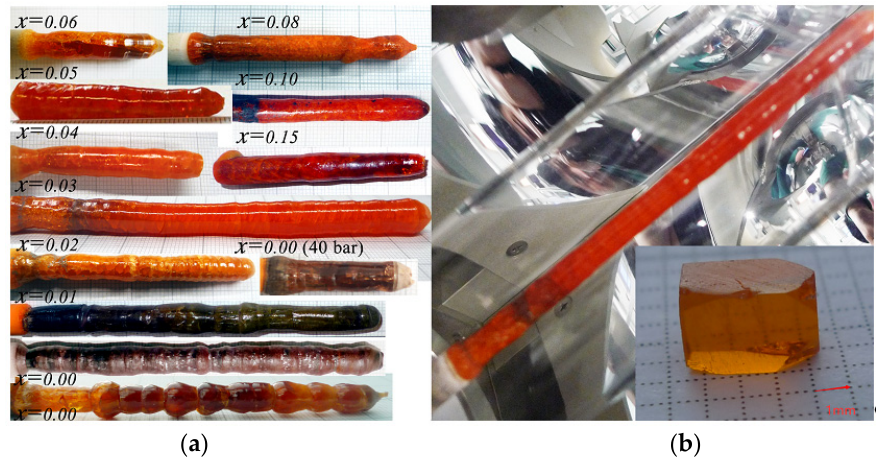
Figure 1. ( a ) As-grown crystals of Li(Mn 1- x ,Ni x )PO 4 with different Ni-doping concentrations, and among them the size of Li(Mn 0.97 ,Ni 0.03 )PO 4 is up to 5 mm (D) × 120 mm (L); ( b ) As-grown Li(Mn 0.97 ,Ni 0.03 )PO 4 single crystal and the samples cut from it.